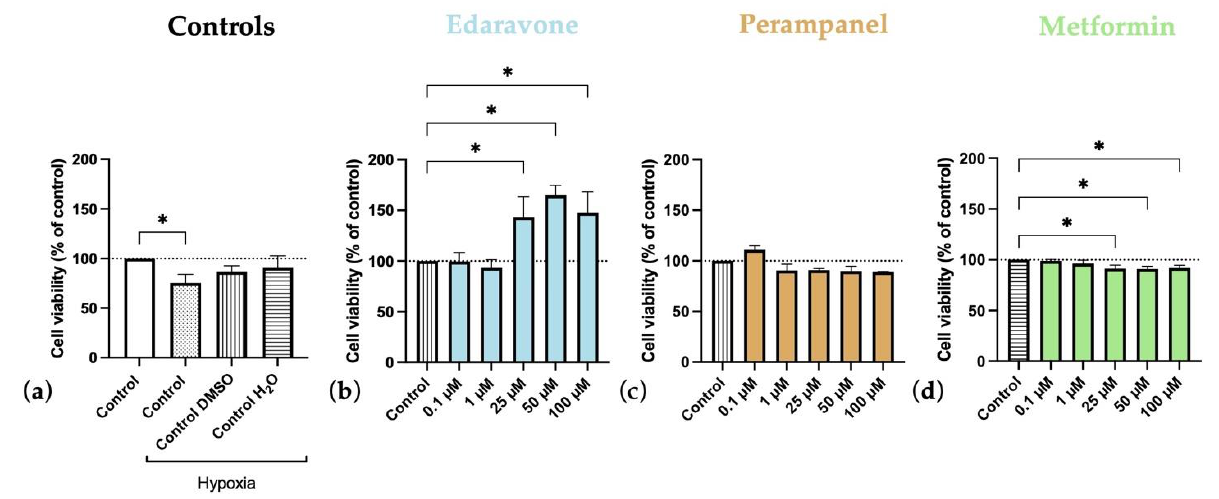
Figure 7. Effects of 24 h of hypoxia followed by 24-h exposure to edaravone, perampanel, and met- formin on HT-22 cells viability. ( a ) Controls graph, comparing controls/vehicles in hypoxic conditions to normoxia ones. ( b ) Edaravone, ( c ) Perampanel, and ( d ) Metformin treatments, after 24 h under hypoxia. Cell viability was assessed by MTT assay. Results are expressed as the percentage of cell viability relative to the respective untreated hypoxia control cells in ( b – d ). * p < 0.05 when compared to hypoxia control. All data are presented as the mean + SEM of three independent experiments.